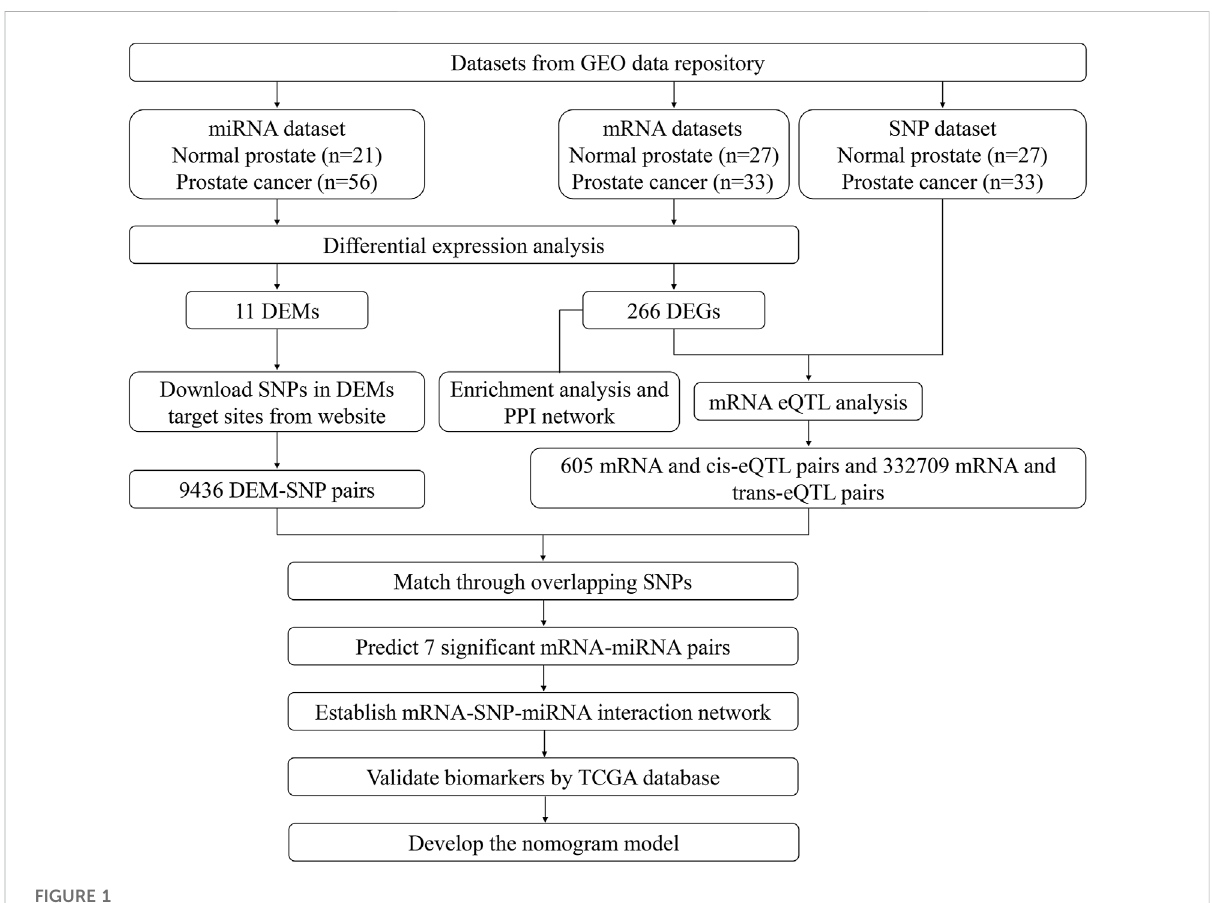
FIGURE 1 Flow chart of study